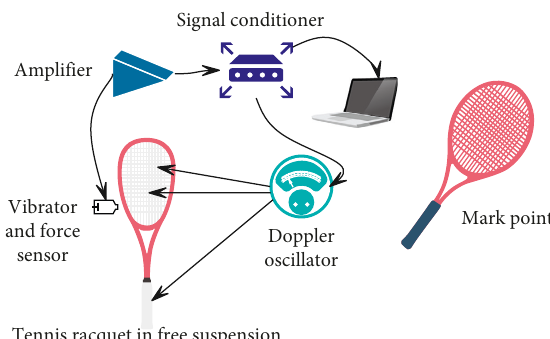
Figure 2: Tennis racket vibration mode test system.